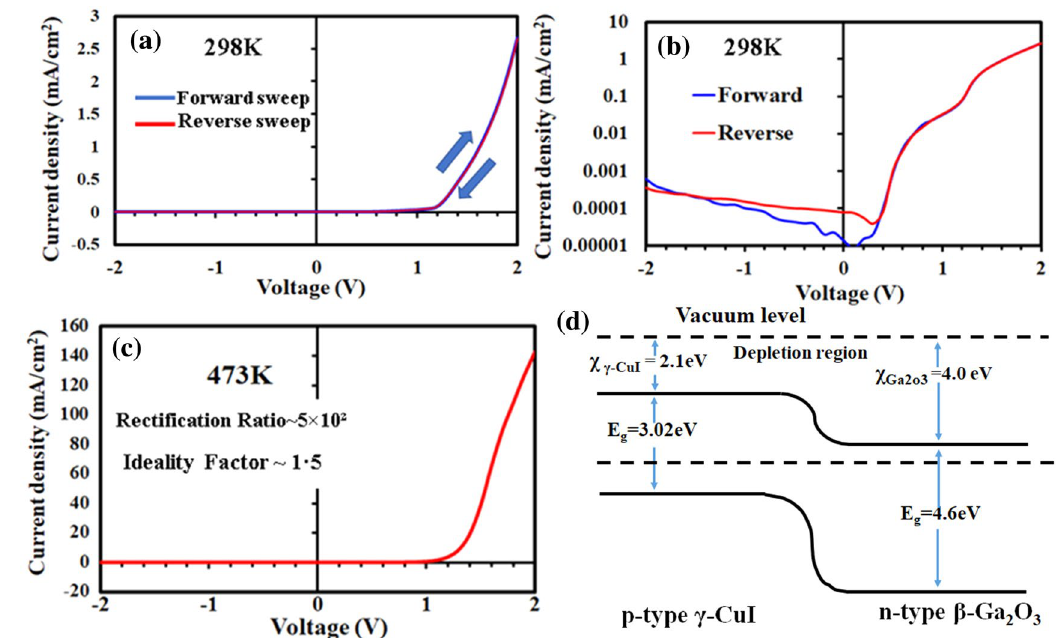
junction device at a significantly higher temperature of 473 K with excellent rectification characteristics; and d energy bandgap dia- gram of the γ-CuI/β-Ga O /In hetero- O heterojunction device in 2 3 2 3